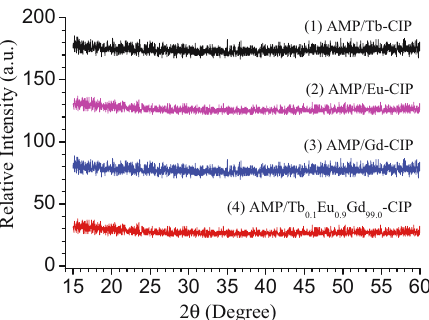
Figure 2: XRD analysis of ( 1 ) AMP/Tb - CIP, ( 2 ) AMP/Eu - CIP, ( 3 ) AMP/ Gd - CIP, and ( 4 ) AMP/Tb 0.1 Eu 0.9 Gd 99.0 -